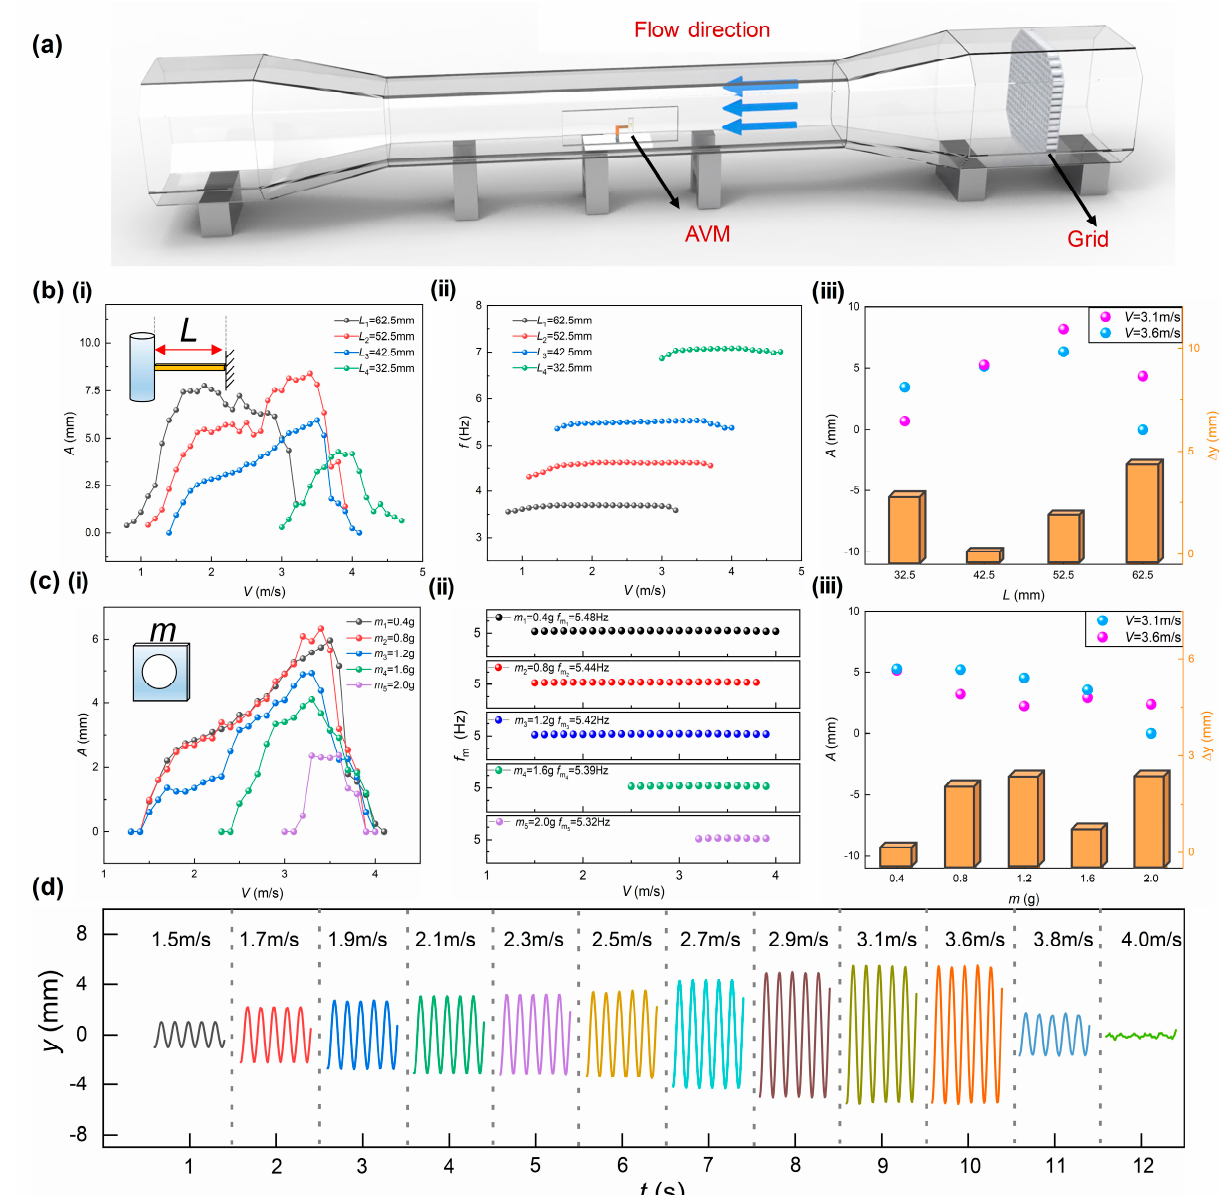
Figure 3. Optimization of vortex vibration parameters. ( a ) Schematic of the experimental apparatus; ( b ) vibration characteristics of AVM under beams with different length: (i) vibration amplitude, (ii) vibration frequency, (iii) D − value of amplitude; ( c ) vibration characteristics of AVM under different mass slider: (i) vibration amplitude, (ii) vibration frequency, (iii) D − value of amplitude; ( d ) real − time vibration signals of AVM at different wind